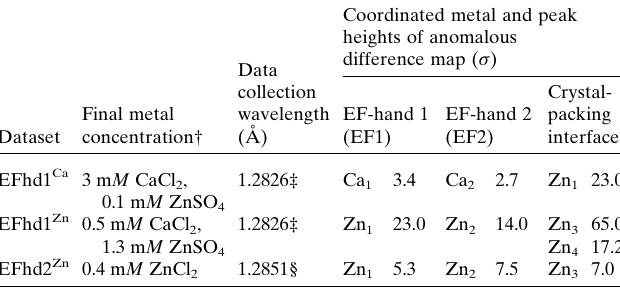
Table 3 Peak heights of the anomalous difference map of EFhd1 Ca , EFhd1 Zn and EFhd2 Zn